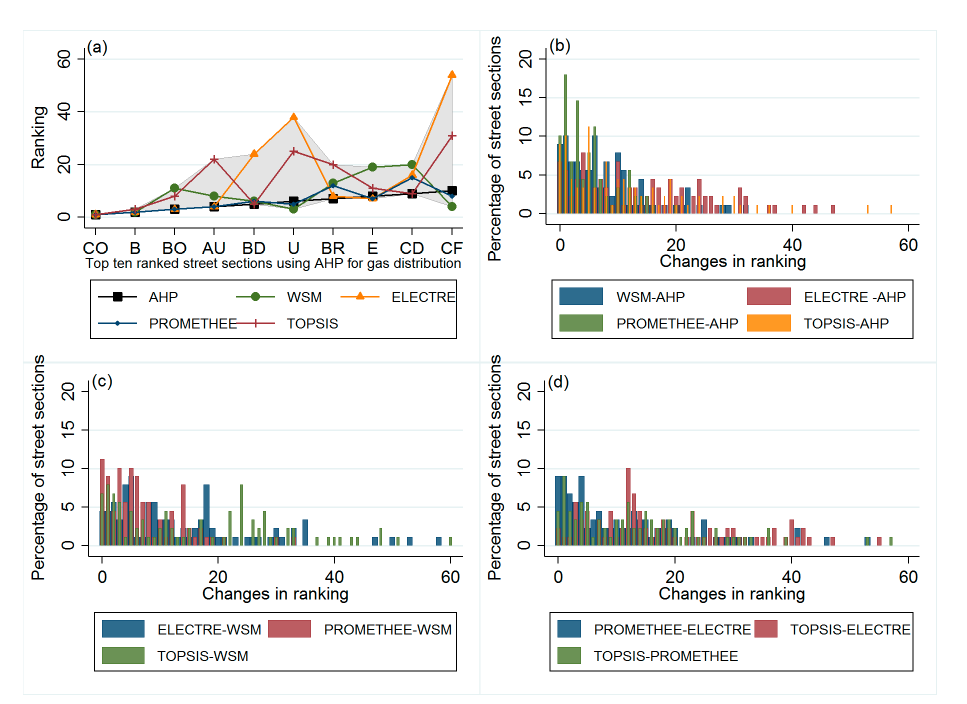
Figure 11. Comparison of the rankings of the gas distribution system using the different methods: ( a ) for the 10 top ranked street sections; ( b ) the absolute ranking differences with the AHP; ( c ) the absolute ranking differences with the WSM; and ( d ) the absolute ranking differences with ELECTRE and PROMETHEE. Table 7. Standard deviation σ of the gas distribution network ranking between the different used methods.